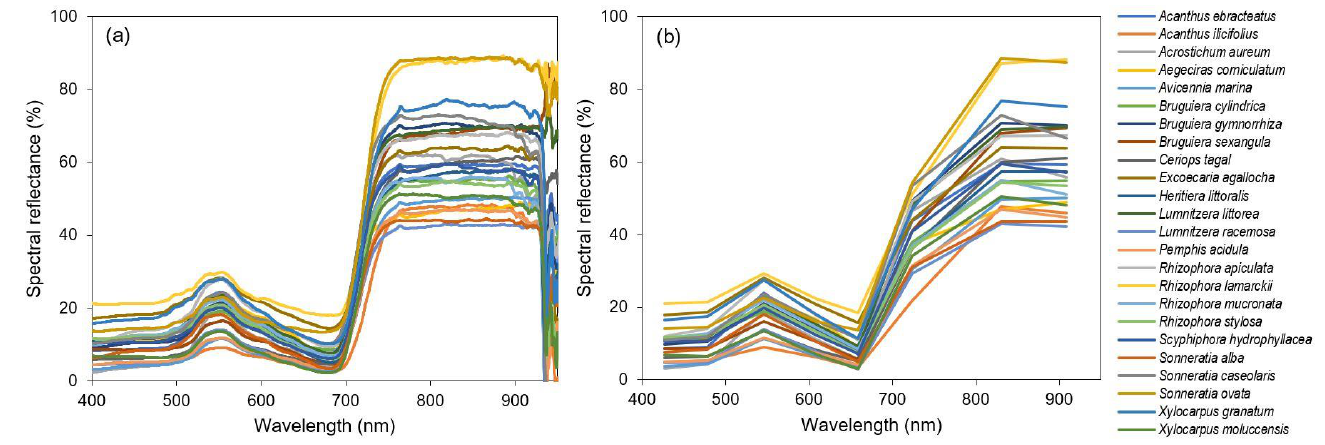
Figure 4. Spectral reflectance curves of the field-measured data ( a ) and the resampling results based on WorldView-2 bands ( b ) for the 24 mangrove species found in the study site.